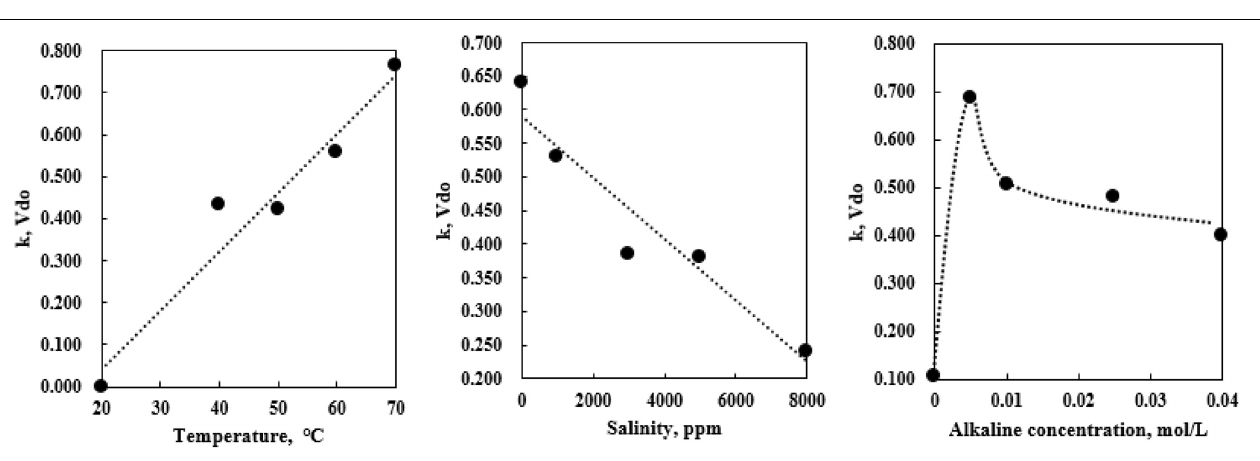
FIGURE 7 | k n (V dw ) trend with changing control factors of NaOH orthogonal bottle test.